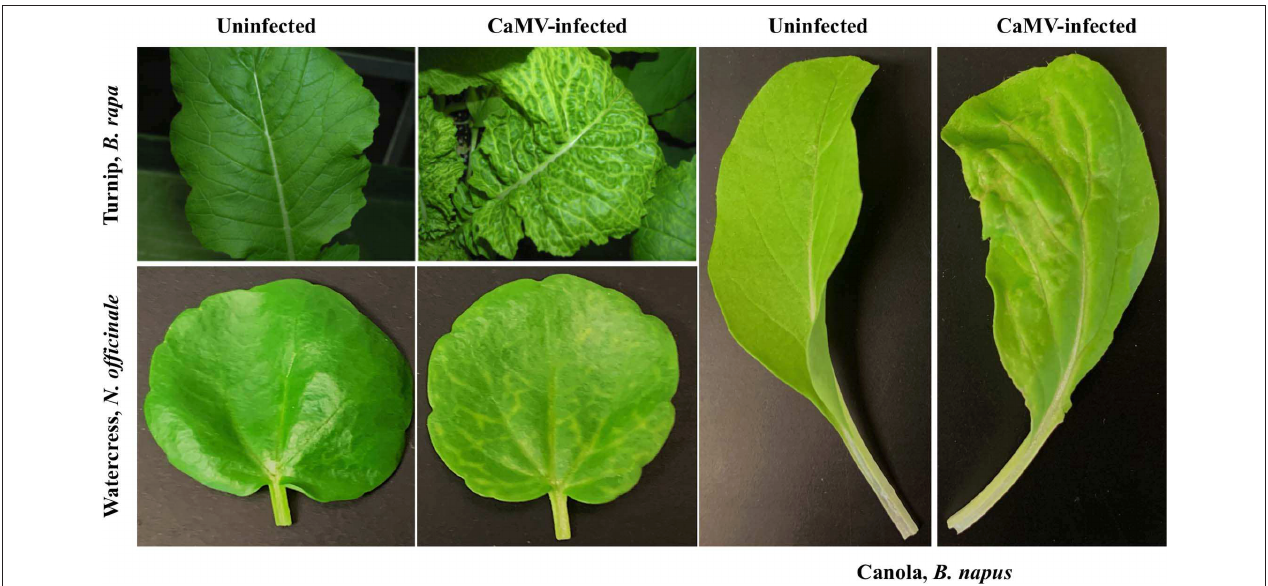
FIGURE 2 | CaMV symptoms on leaves. For each plant type, the left panel shows an uninfected leaf and the right panel shows a leaf from a CaMV-infected plant with typical symptoms, such as mosaic (mottling, e.g., lighter and/or darker green patches, puckered or curled leaves) or vein clearing (yellow or white veins). Top left: turnip ( Brassica rapa ), bottom left: watercress ( Nasturtium officinale ), right: canola ( Brassica napus